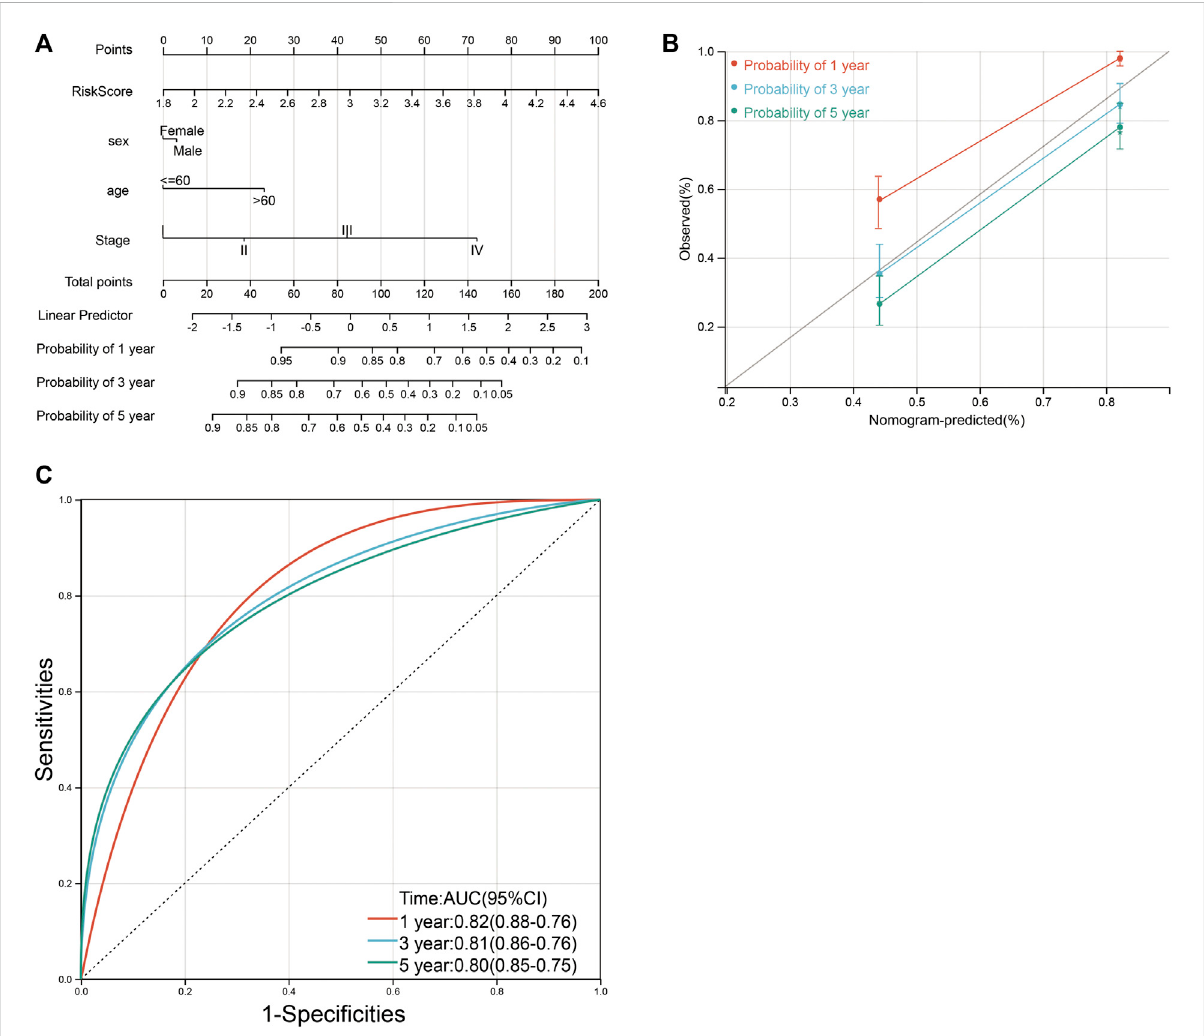
FIGURE 11 Nomograms and calibration plots for predicting outcomes in gastric cancer patients based on risk scores. (A) Nomogram for predicting 1-, 3-, and5-yearevents,combiningclinicaldatawithage,sex,tumorgrade,andriskscore.Thelinesegmentcorrespondingtoeachvariableismarkedwith ascale,indicating thevaluerange ofthevariable, and thelengthof thelinesegment re fl ects thecontribution ofthefactor totheresulting event.The Point in the fi gure represents the individual score corresponding to each variable under different values, and the sum of the corresponding individual scores after taking all the variables. (B) Calibration plot for predicting overall survival. (C) ROC curve was used to verify the diagnosis with AUC at 1-, 3-, and